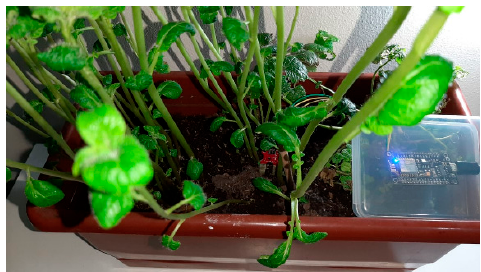
Figure 3. Prototype of ESP8266 and Sensor FC-28 in potato cultivation.